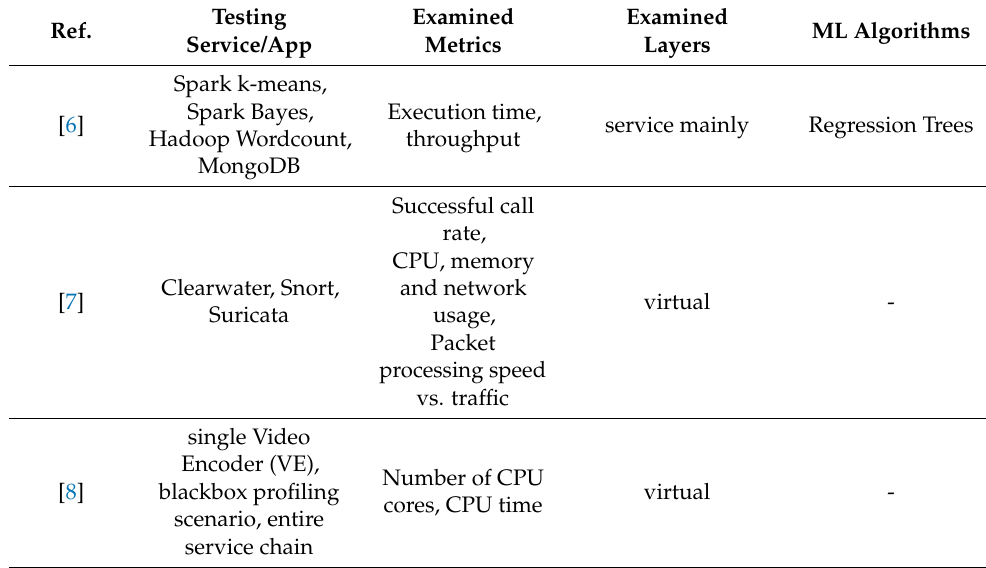
Table 1. Related work in the context of